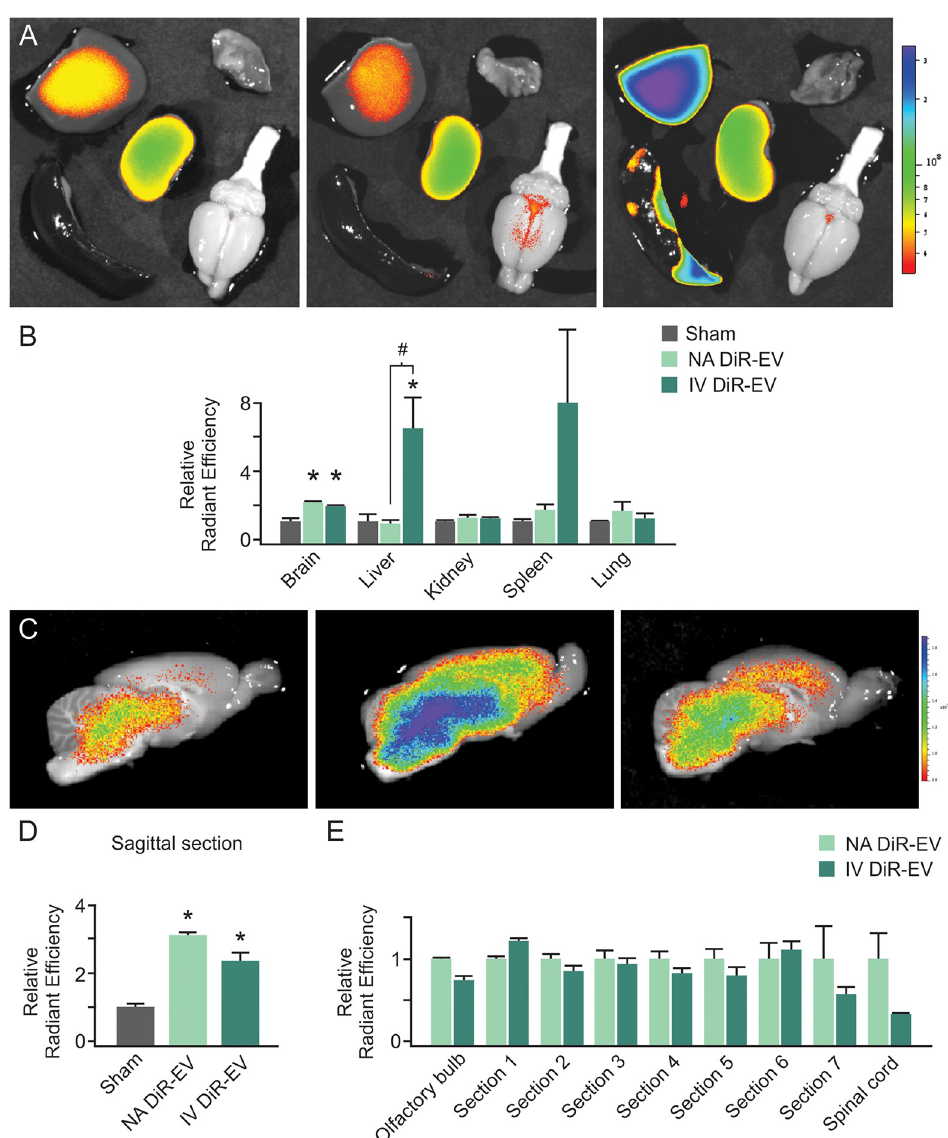
Fig 3. Comparison of intranasal versus intravenous delivery of IFN γ -DC-EVs. (A) Representative images of explanted organs at one hour post-administration of Xenolight DiR-labelled EVs. (Top row: liver and lung; middle: kidney; bottom row: spleen and brain) [Left to right: Sham, nasally administered (NA) DiR-EVs, intravenously delivered (IV) DiR-EVs]. Sham controls consisted of intravenously administered Xenolight DiR-labelled exosome-free (non-conditioned) medium prepared in the same manner as conditioned media for labelling of EVs. (B) Quantification shows significantly higher ( � p < 0.001) signal in nasally administered and intravenously delivered DiR-EV brains, and significantly higher ( � p = 0.027) signal in intravenously delivered DiR-EV liver. There was also a significant difference (# p = 0.050) between liver DiR-EV fluorescence in intravenously versus nasally treated animals. No other organ measured showed significant differences. (C) Representative images of 3 mm thick sagittal sections of brain [Left to right: sham, nasally administered DiR-EVs, intravenously delivered DiR-EVs]. (D) Quantification of sagittal sections showed significantly ( � p < 0.001) increased signal in both nasally administered and intravenously delivered DiR-EV administered animals versus sham. (E) Quantification of additional brain areas showed no significant difference in CNS distribution between delivery routes (Sections 1–7 defined as in Fig 1). ( n = 3-4/group; A-E).